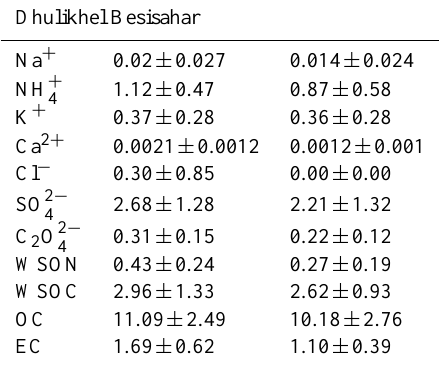
Table 2. Ionic and Organic concentrations of aerosols sampled in Site A (4 to 25 May 2009) and Site B (28 May to 6 June) during the late pre-monsoon season 2009. All units are in µg/m 3